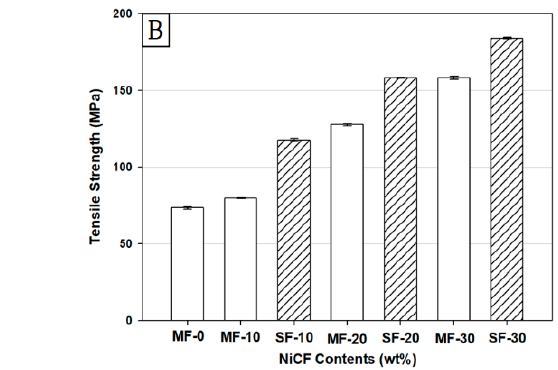
Figure 8. Comparisons of ( A ) the tensile modulus and ( B ) the tensile strength of the MF-NiCF/PA6 and SF-NiCF/PA6 composites with various NiCF contents.